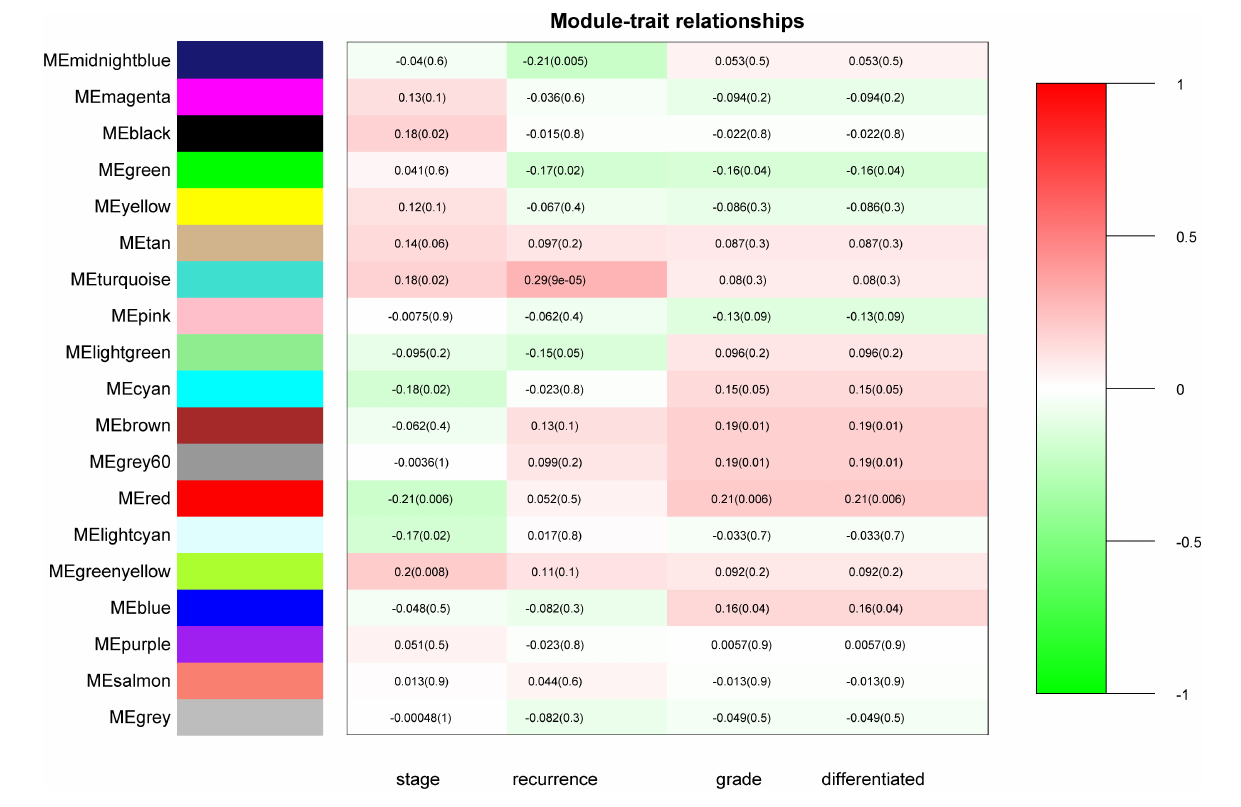
Frontiers in Genetics |